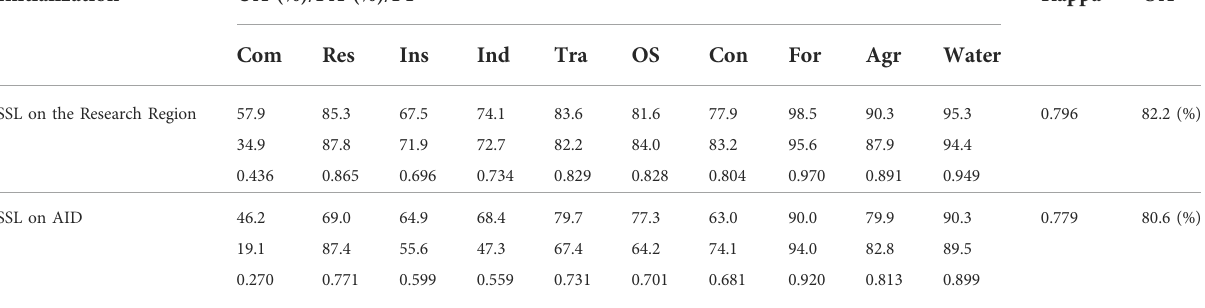
TABLE 5 Quantitative result of the models pretrained on the research region and AID.